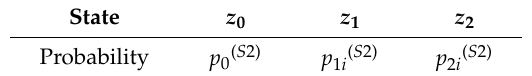
Table 2. Probability determination for particular states of the S 2 network